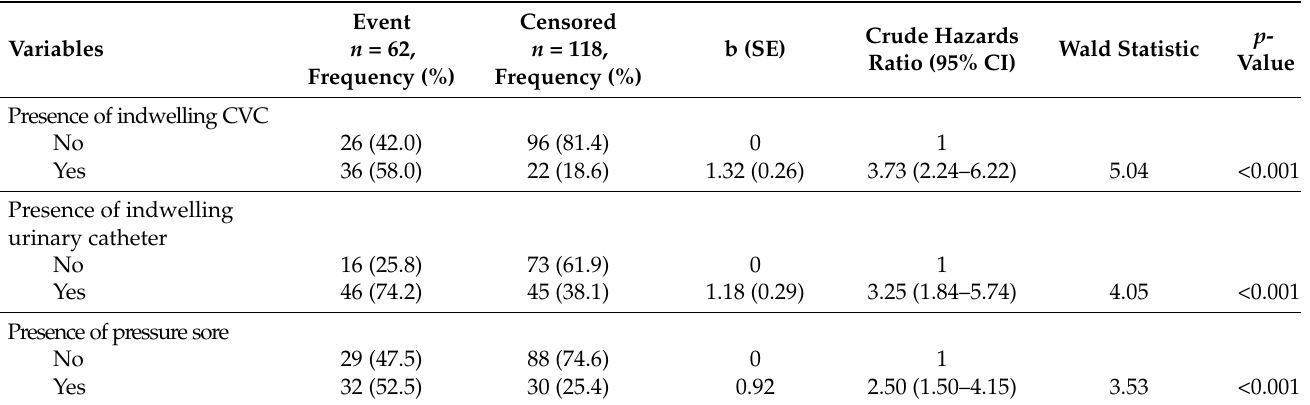
Table 6. Pressure sore and device related factor of all-cause 30-days mortality in patients suspected with bacterial infection on extended or restricted antibiotic using simple Cox proportional hazards regression model ( n = 180).